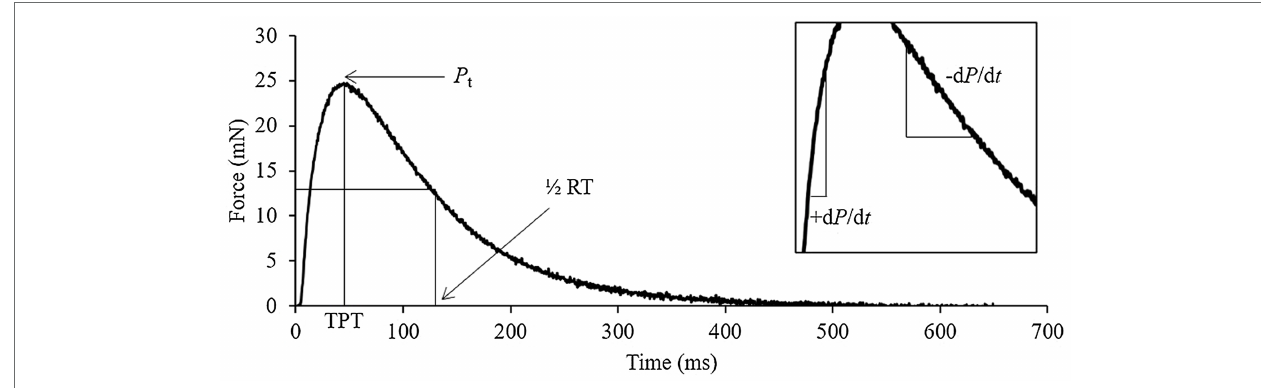
FIGURE 1 | Representative soleus twitch trace identifying the key quantifiable measures of contraction. P t , peak twitch; TPT, time to peak tension; ½ RT, half-relaxation time; +d P /d t , rate of force development; and − d P /d t , rate of force